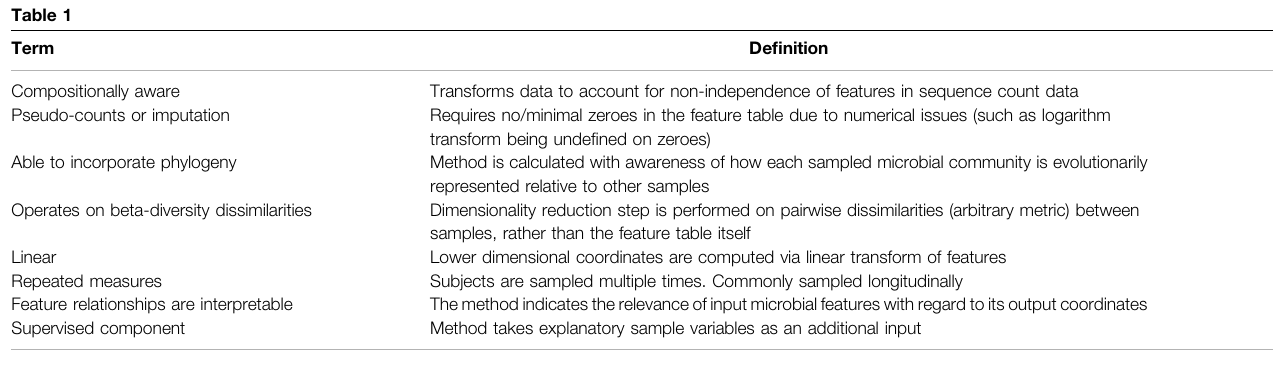
TABLE 1 | Common characteristics of strategies for dimensionality reduction address different aspects of the data. Table 1 Term De fi nition Compositionally aware